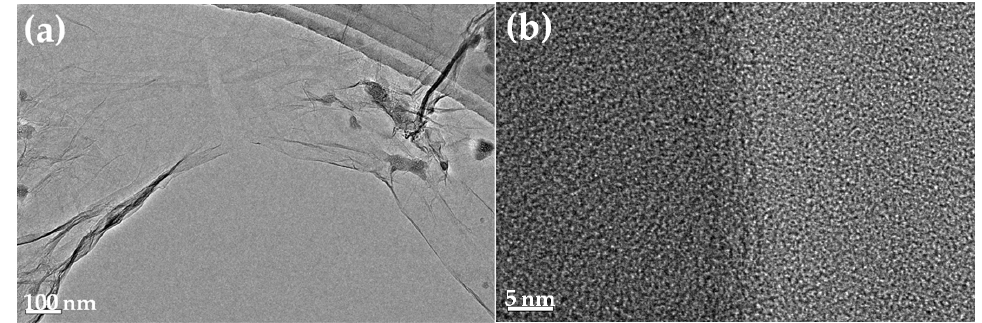
Figure 3. TEM images of GONSs: ( a ) the observed ridge or crease demonstrating a wrinkled surface texture of GONSs; and ( b ) the observed 'honeycomb' exhibiting a graphene network structure.